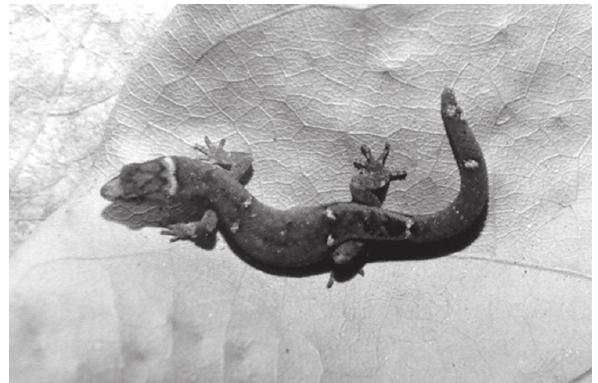
Figure 1. Coleodacylus natalensis Freire, 1999. Photo by Helianne de Niemeyer.